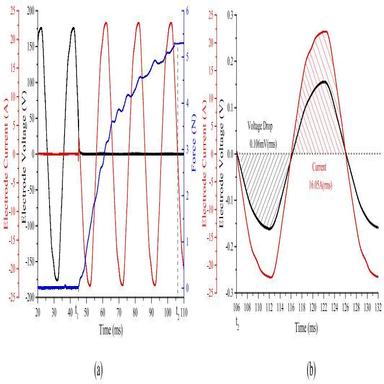
The measured example of force signal, electrode voltage and current during closing process. (a) Waveforms from 20 to 110 ms. (b) Waveforms from 116 to 142 ms.